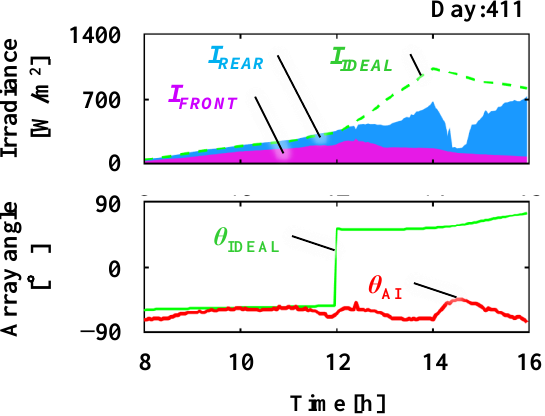
Figure 10. Time variation on day 411. Cloudy in the morning and sunny in the late afternoon, when AI control works less well (albedo = 0.5, RUN 1).